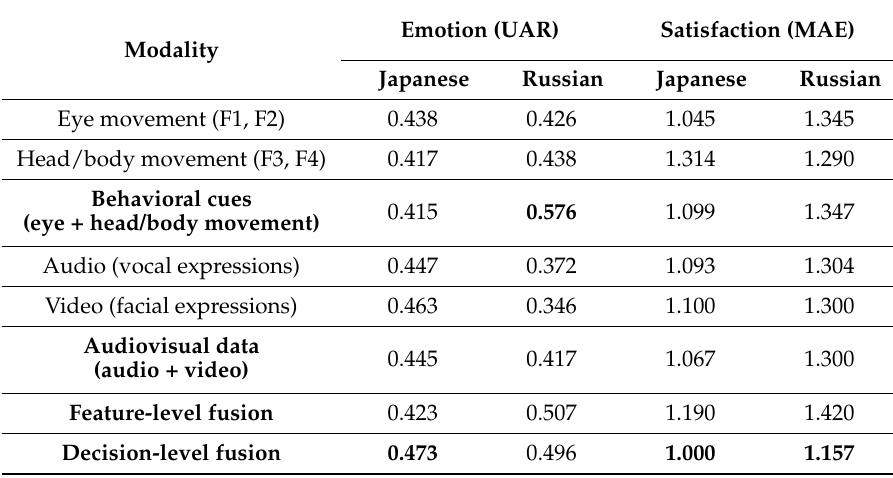
Table 2. Performance of tourist emotion and satisfaction estimation (by nationality of participants). The best performances are highlighted with bold